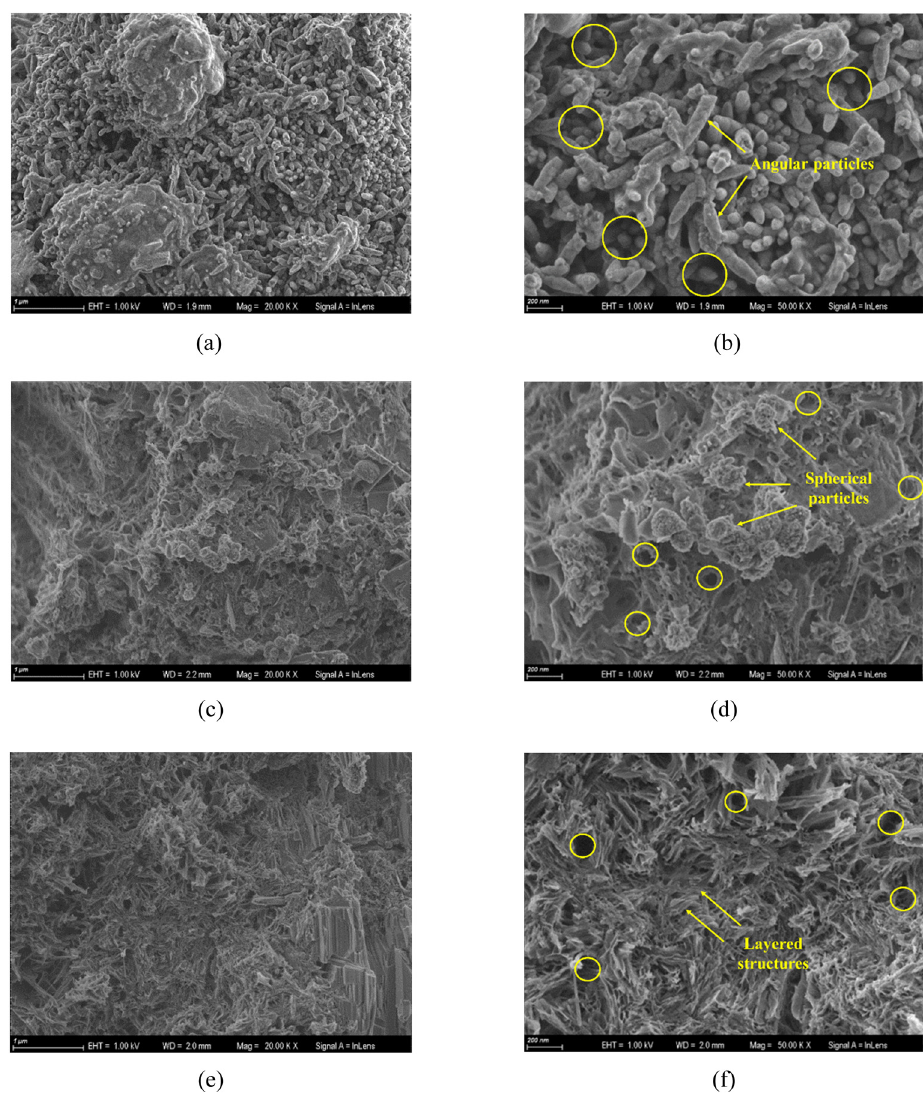
Figure 13: Microstructure images of three mortar samples. ( a ) S0 20,000 × , ( b ) S0 50,000 × , ( c ) S1 20,000 × , ( d ) S1 50,000 × , ( e ) S2 20,000 × , and ( f ) S2 50,000 × .